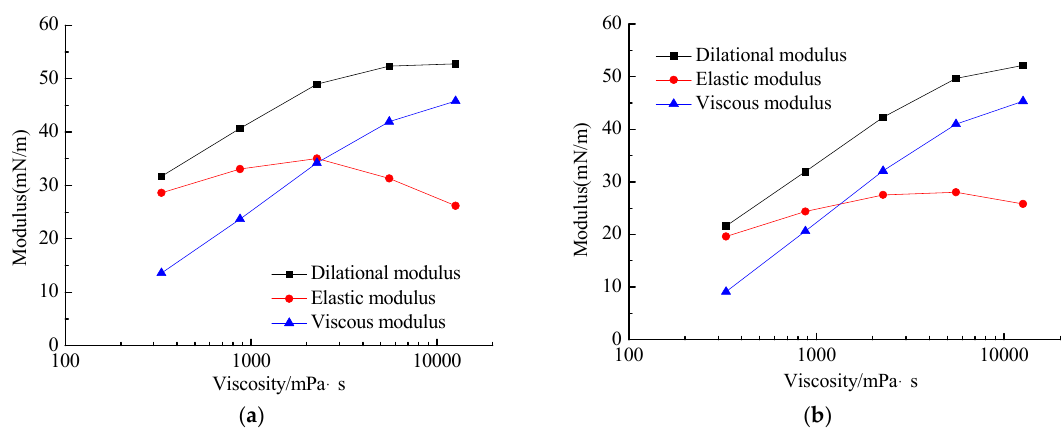
Figure 12. Changes in viscoelastic moduli with viscosity: ( a ) asphaltenic oil; ( b ) deasphalted oil.